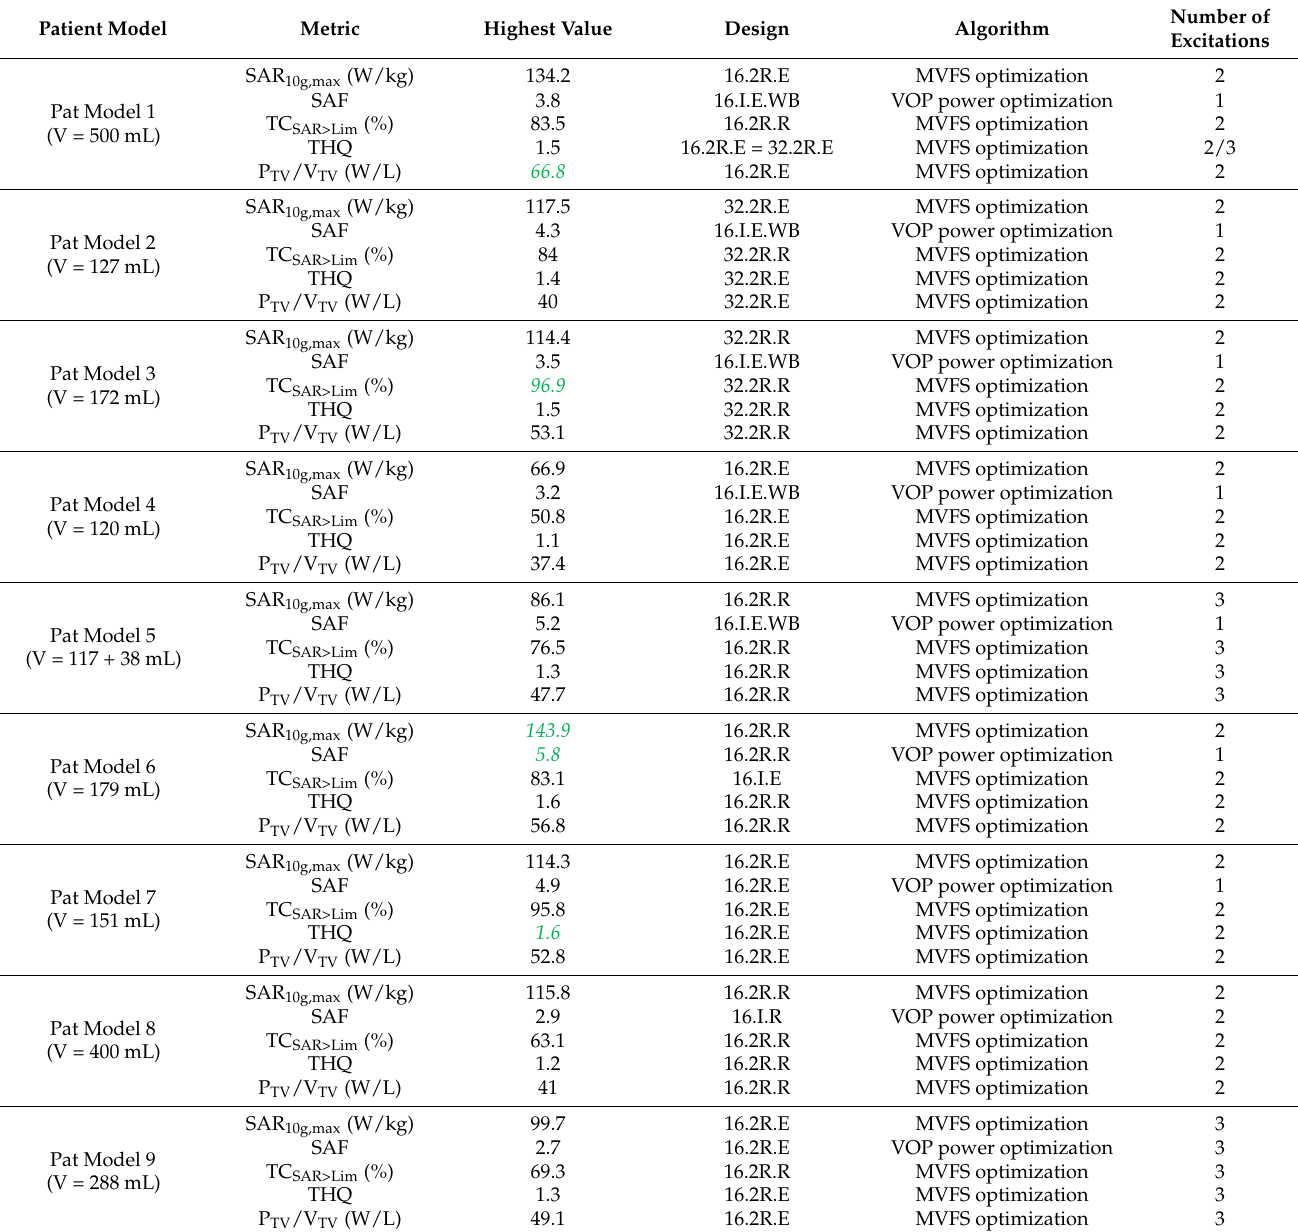
Table 1. Summary of the highest values achieved for each patient model and metric together with the RF applicator design, optimization algorithm used, and number of excitations to yield the calculated RF exposure patterns by time-interleaved application. The overall maxima are highlighted in green italic. For the full table of HTP results, please refer to the Supplementary